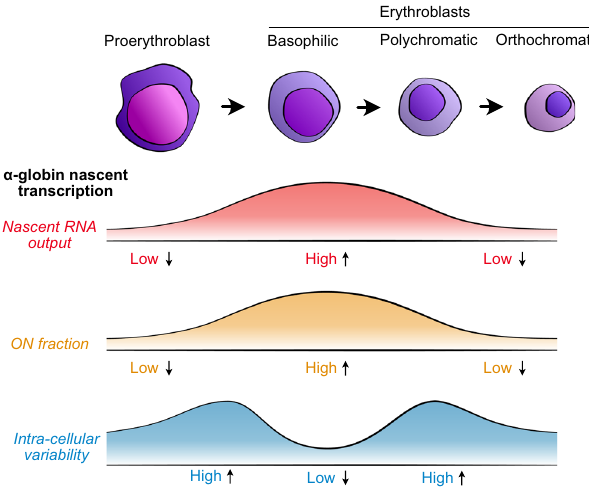
Fig.6|Schematicofobservedchangesintranscriptionaloutputandvariability of α -globin as cells progress through erythropoiesis. Previous work has descri- bed the sequential changes in the transcriptional, epigenetic, and chromosomal architecture ofthe α -globin locus throughout differentiation 19 . From thiswork, we fi nd that nascent transcription is low in proerythroblast cells, peaks in the mid- stages of terminal differentiation around the basophilic erythroblast stage, before declining at later stages. This is primarily driven by the fraction of time for which α -globin is active in cells (ON fraction). We speculate that this is likely due to increased likelihood of contacts between the α -globin enhancers and promoters during differentiation as we have recently described 17 . In contrast, the relative variability of nascent transcription in individual cells is maximal either side of the peak in overall activity, and lowest when the gene is most strongly active in the population. This reduced intra-cellular variability in nascent transcription may occur as a result of formation of a more stable transcriptional hub while the gene activity is maximal in